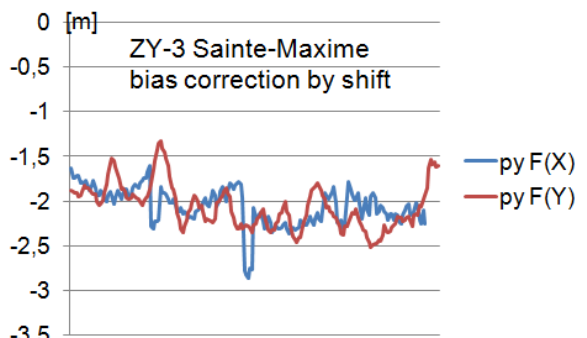
Figure 4. Systematic y-parallaxes of Ziyuan-3 (3.4m GSD) for bias correction by